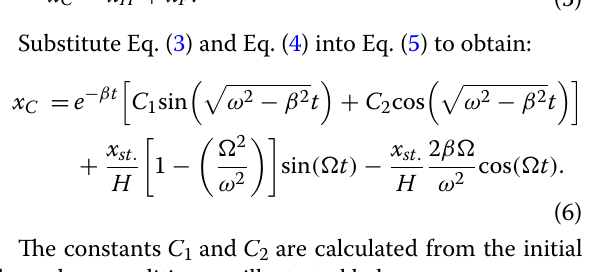
0, x C 0, B.C. (2) at t = =